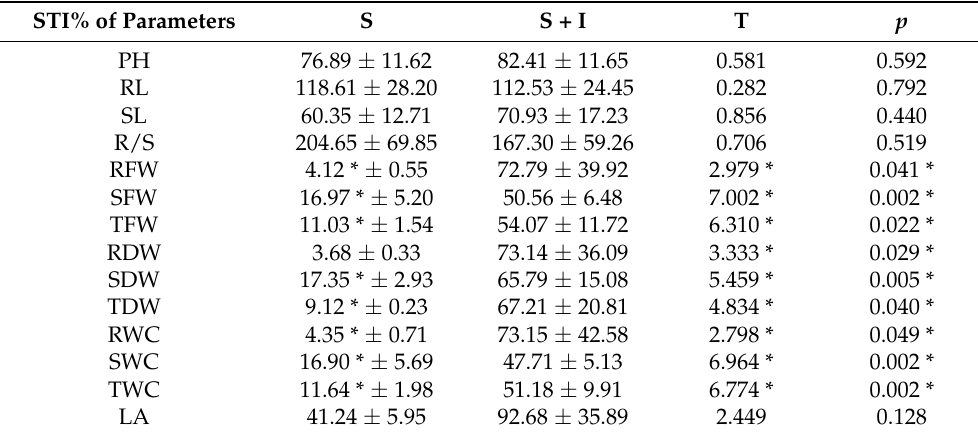
Table 1. Solanum melongena L. salt tolerance indices percentage as affected by 200 mM NaCl (S) and/or inoculum (I)